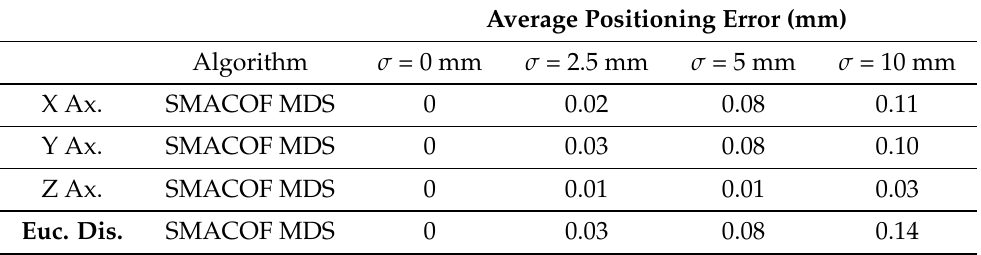
Figure 5. Simulated infrastructure-positioning results for different noise levels using SMACOF MDS (MDS). Table 1. Simulated infrastructure-positioning average error (of the nine anchors) for different noise levels with SMACOF MDS, per-axis and Euclidean